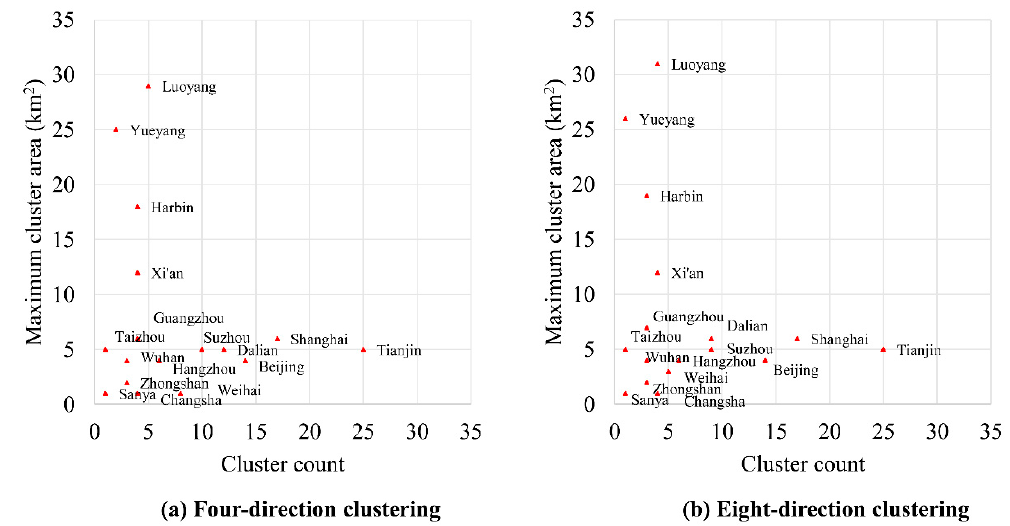
Figure 7. ( a – b ) Relationship between the cluster count and maximum cluster area for prefecture-level divisions in China, in 2017. Those prefecture-level divisions that did not have any clusters are not shown.